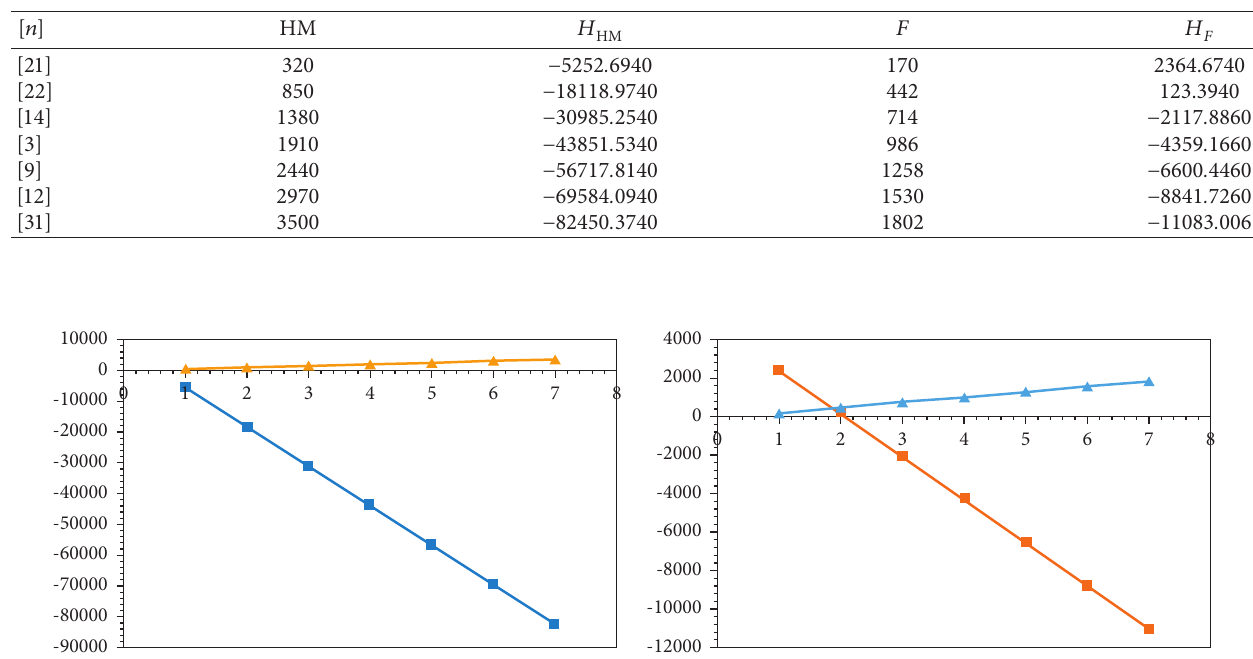
Table 7: Comparison of HM and F indices with their respective heat of formation for GST − SL [ n ] .